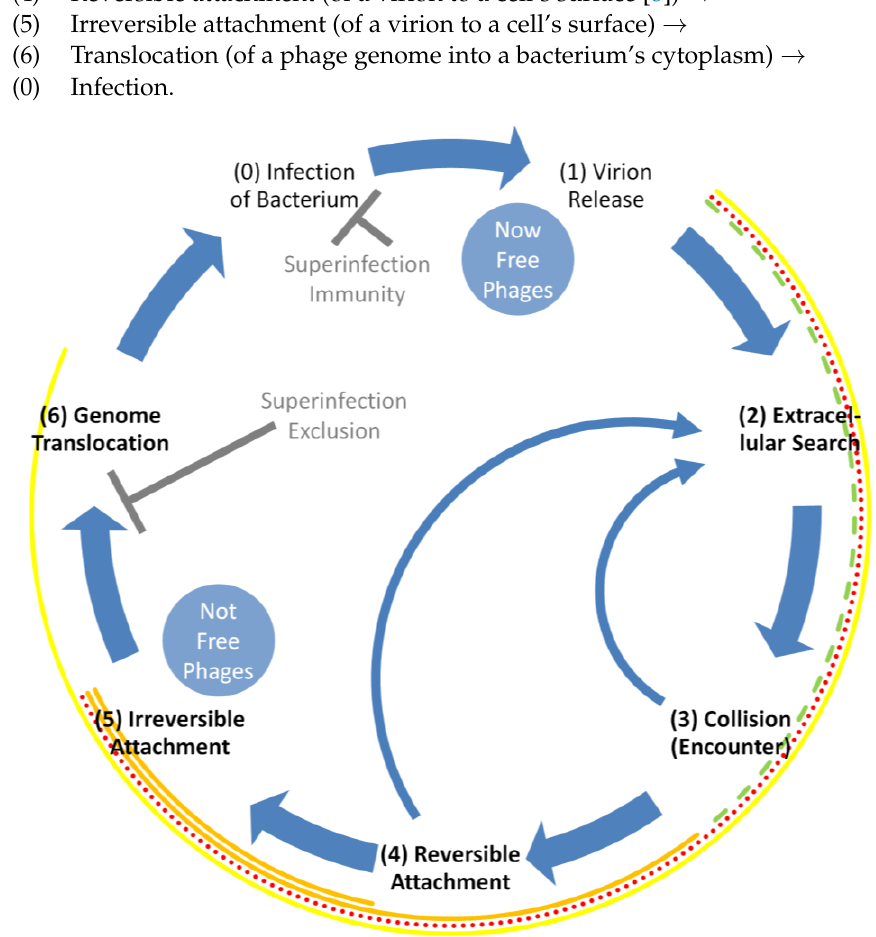
Figure 2. Life cycle of a bacteriophage with emphasis on phage adsorption. At an upper limit, adsorption involves steps 2 through 6. (1) is from a phage-infected bacterium. (2) is for new bacteria to infect. (3) is of a virion with a bacterium. (4) can be followed either by irreversible attachment to a bacterium’s surface (5) or instead a return to the extracellular search (as too can collision be followed by return to the extracellular search if reversible attachment fails to occur; both of these return processes are shown as narrow, curved arrows). (6) is into a bacterium’s cytoplasm. Superinfection exclusion [14–16], if present (first inhibition arc, “ ⊥ ”, middle-left), can serve as a block on this genome translocation. Though not otherwise considered here, contrast superinfection exclusion with superinfection immunity, where the latter represents instead a type of post-translocation block on the progression of a phage infection [17] (second inhibition arc, top-center). The surrounding, multicolored arcs represent different perspectives on how the processes of adsorption might be described. These range from just irreversible attachment (innermost, orange arc) to a combination of reversible and irreversible attachment (second-innermost, orange arc) to the extracellular search through irreversible attachment (third-innermost arc; shown as both red and dotted) to the extracellular search through phage genome translocation (outermost yellow arc). In terms of adsorption rates, it is as represented by the dotted-red arc that is relevant, though much of the consideration here is on just step (2) as ending in step (3) (dashed-green arc). At a maximum, all but infection (0) and release (1) are explicitly associated with the adsorption process. Reversible and irreversible attachment can also be described as reversible or irreversible adsorption . See Table 1 for adsorption-related